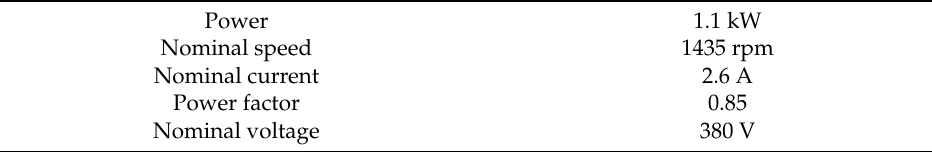
Table 1. Induction motor